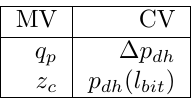
Table 2: Manipulated and controlled variables for the CSP ref. tracking scenario.